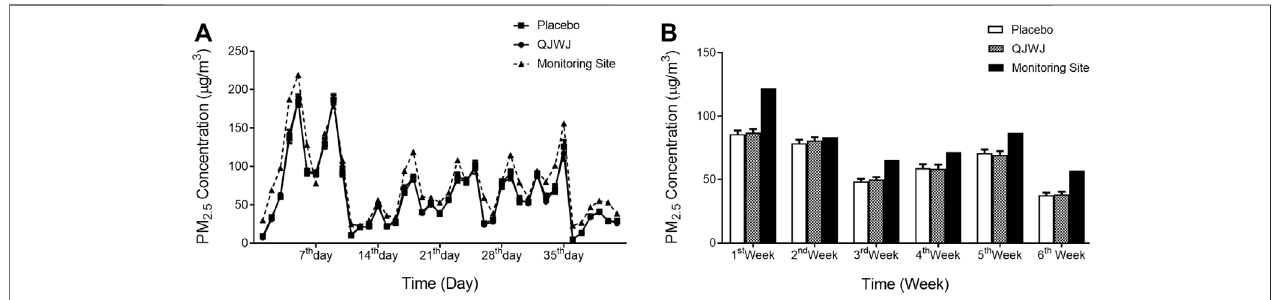
FIGURE 2 | PM 2.5 concentrations (mean and SEM) during the study period. (A) Average daily PM 2.5 concentrations; (B) Average weekly PM 2.5